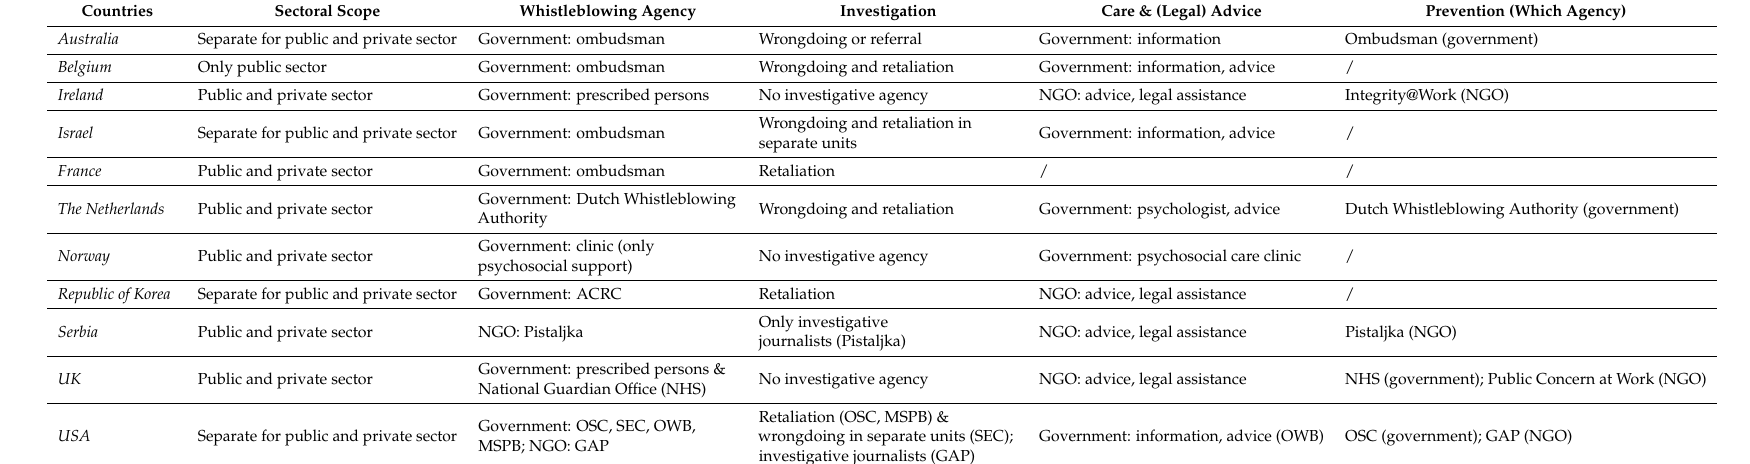
Table 2. Summary of whistleblowing arrangements concerning external recipients of concerns in 11